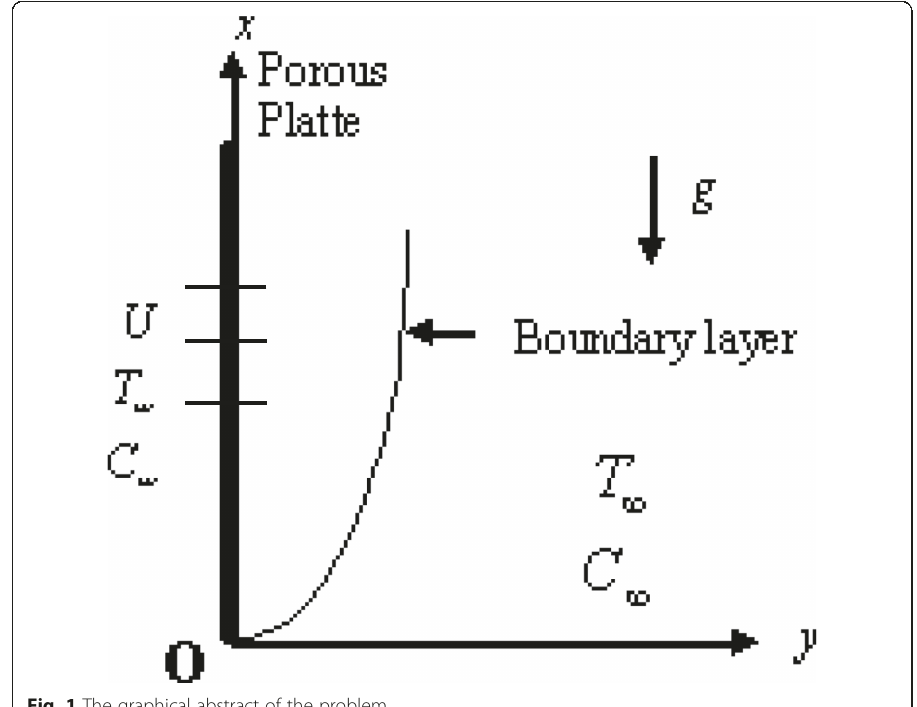
Fig. 1 The graphical abstract of the